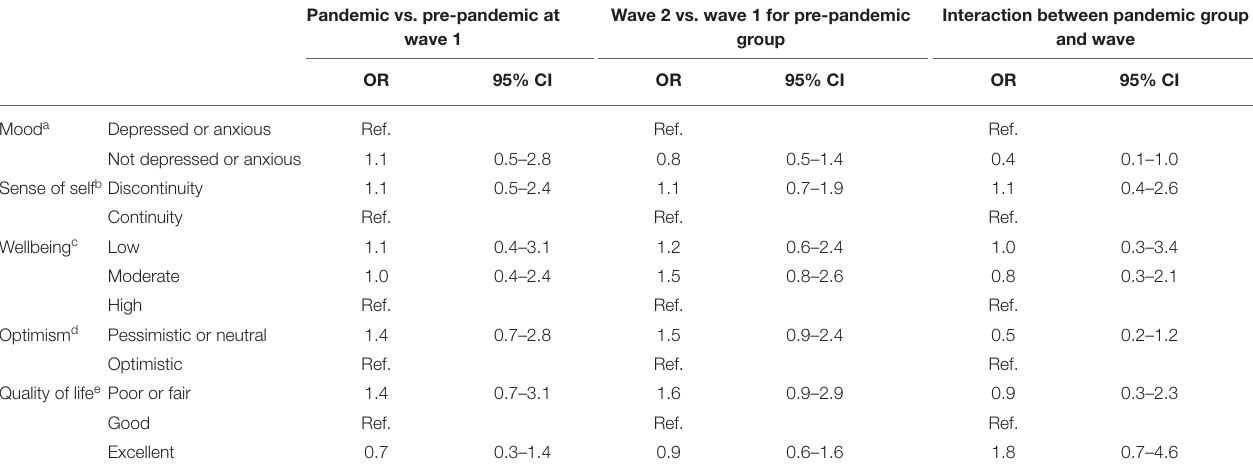
TABLE 3 | Odds ratios from mixed effect logistic regression models and multinomial logistic regression models with 95% confidence